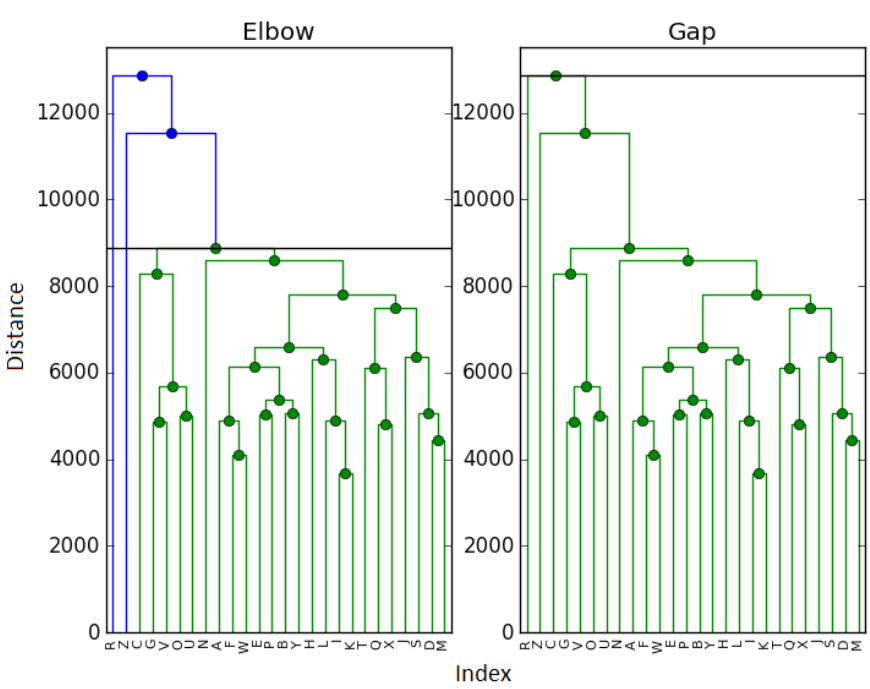
Figure 5. Clustering of the ExpressionSet.